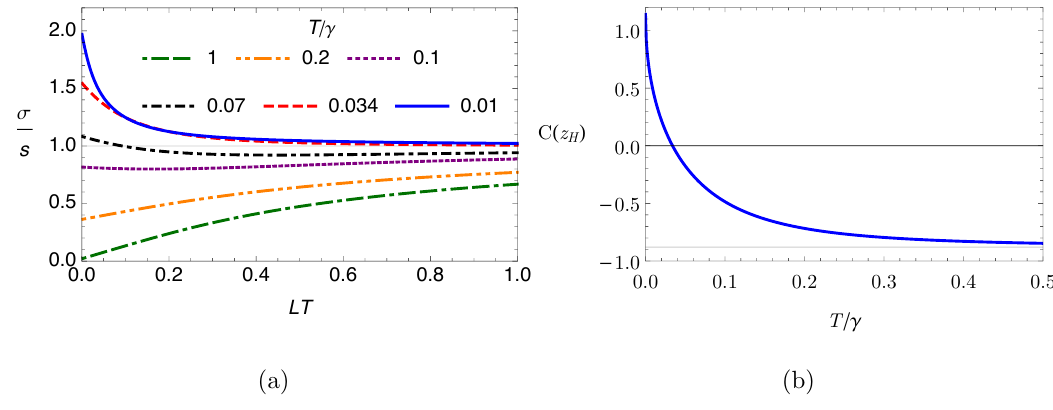
Figure 17. (a) The ED, (cid:27) , in units of entropy density s , versus LT for the strip in the solution of eq. (7.4) with (cid:22)=T = 0, showing the intercept increase and the slope change sign at small LT as T=(cid:13) decreases from 1 to 0 : 01. A transition to area theorem violation also occurs at T=(cid:13) (cid:25) 0 : 034 (b) The dimensionless coe(cid:14)cient C ( z H ) from eq. (2.23) versus T=(cid:13) . As T=(cid:13) ! 1 , C ( z H ) approaches the value for AdS-SCH with d = 3 (the horizontal line). As T=(cid:13) decreases, C ( z H ) becomes positive at T=(cid:13) (cid:25) 0 : 034, indicating area theorem violation.